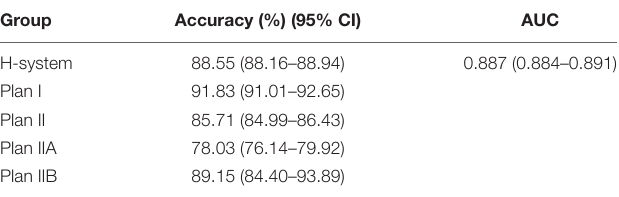
TABLE 2 | Accuracy and AUC of H-system in the testing set.